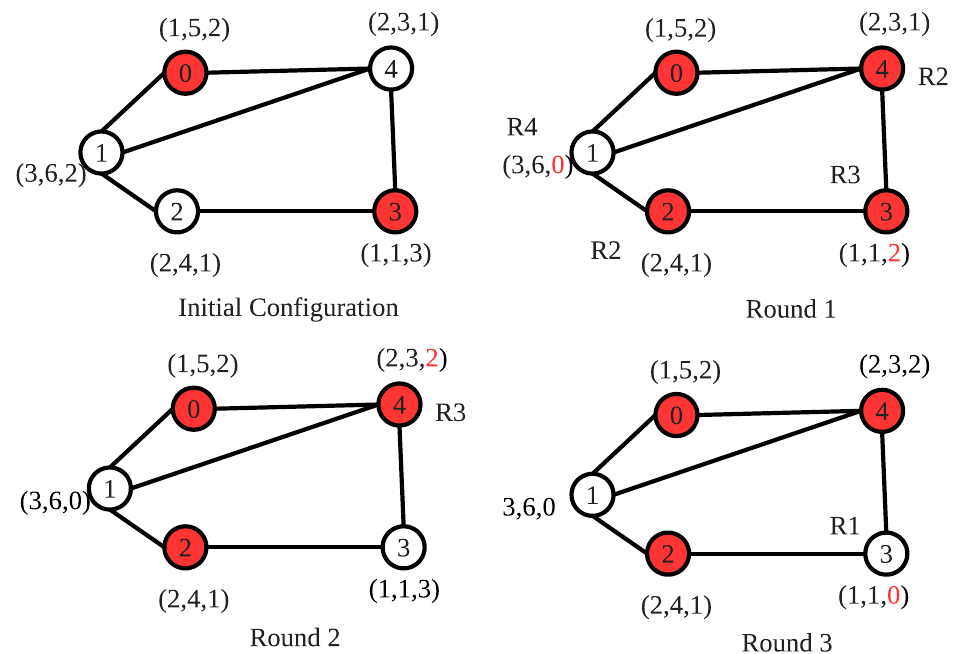
Figure 3. An execution of the SS-CVC 1